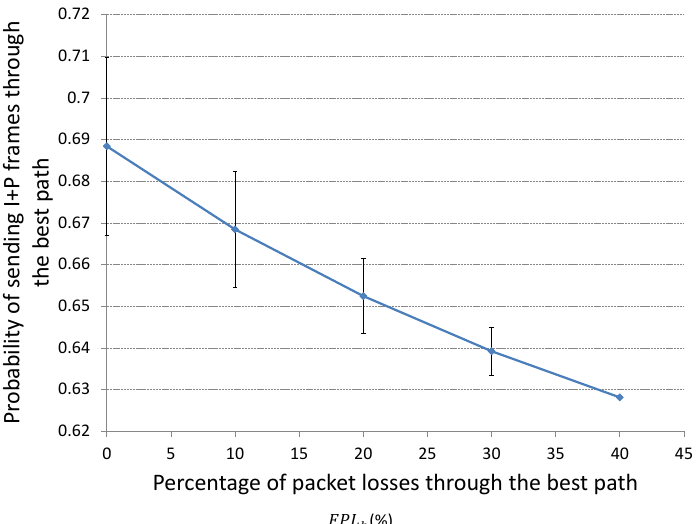
Figure 17. Behaviour of p ∗ as the fraction of packet losses ( F P L ) through the best path i ( F P L ) increases. Here the FPL through the medium-quality path remains b